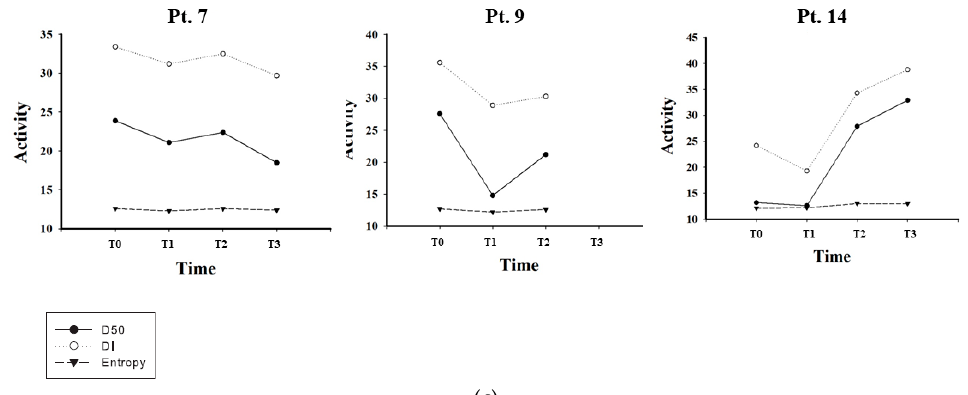
Figure 1. The fluctuations in DI, D50, and entropy (H) along the course of renal transplantation, including the post-transplant immunosuppressive treatments. ( a ) Patients #1, #4, and #6 who underwent rituximab therapy for desensitization before transplantation because of predicted high risks of rejections; ( b ) patients #2, #3, #5, #8, #10, #11, #12, and #13 who exhibited a rapid elevation of D50 after transplantation; ( c ) patients #7, #9, and #14 who had a primary reduction in D50 after transplantation, and all of those who developed T-cell-mediated rejection. All the 1st samples were obtained just before transplantation surgery (T0), except those in desensitized patients (#1, #4, and #6), whose T0 was just before the 1st dose of rituximab infusion. Subsequent sampling times were 30 (T1), 90 (T2), and 360 days (T3) after the transplantation. Patient #9 died from suicide just before T3 because of psychological problems; Pt: patient.